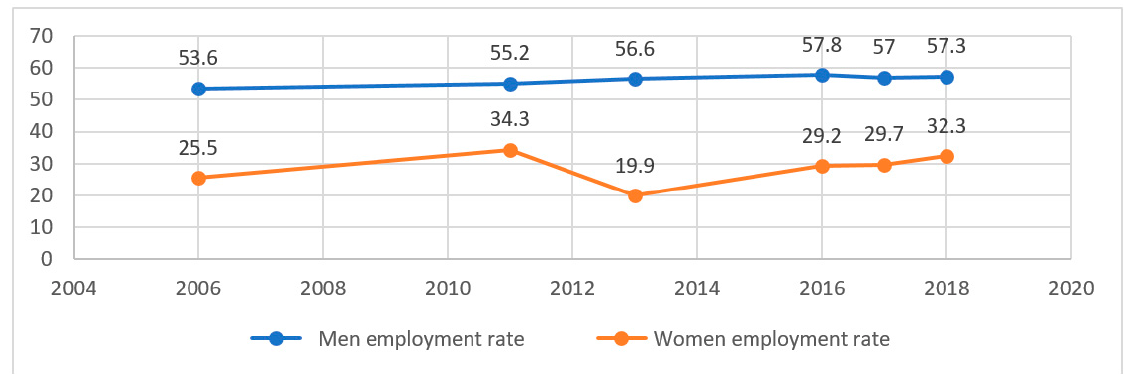
Figure 2. Evolution of the employment rate by gender. Source: Authors, based on ANSD data. From the point of view of the unemployment rate, it should be noted that they developed differently. The unemployment rate for men rose from 7.7% in 2006 to 18% in 2013 and then gradually decreased to 7.4% in 2018 (ANSD 2013). On the other hand, the unemployment rate for women has seen an evolution sawtooth, although there has been a slight increase over the last three years, reaching 26% in 2018 (see Figure 3).